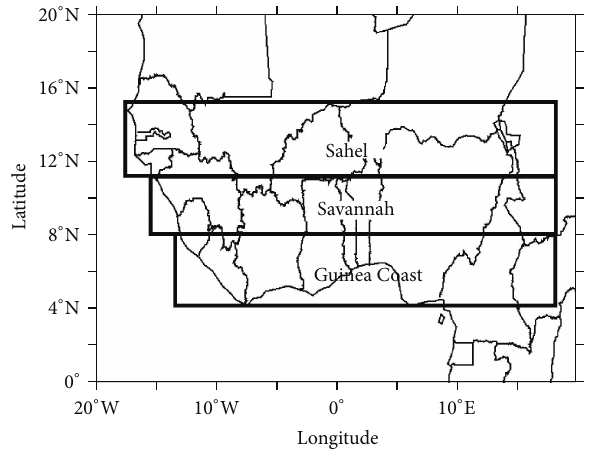
Figure 1: West African domain divided into three climatic zones: Guinea (4 ∘ N–8 ∘ N), Savanna (8 ∘ N–11 ∘ N), and Sahel (11 ∘ N–16 ∘ N) (source: [49, 50]).